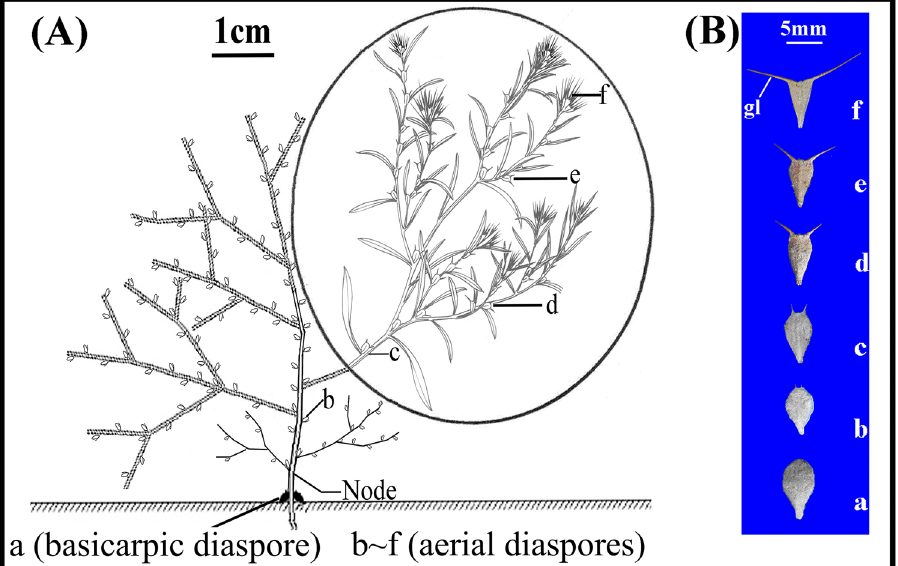
Figure 1. Position of basicarpic (a) and aerial (b–f) dispersal units of Ceratocarpus arenarius on an individual plant ( A ), and morphology of the six dispersal unit morphs of Ceratocarpus arenarius ( B ). The stem of this tumbleweed breaks at the node that is labeled. Circled material from (www.china baike .com). gl, glochid. (from Lu et al. 2015, with